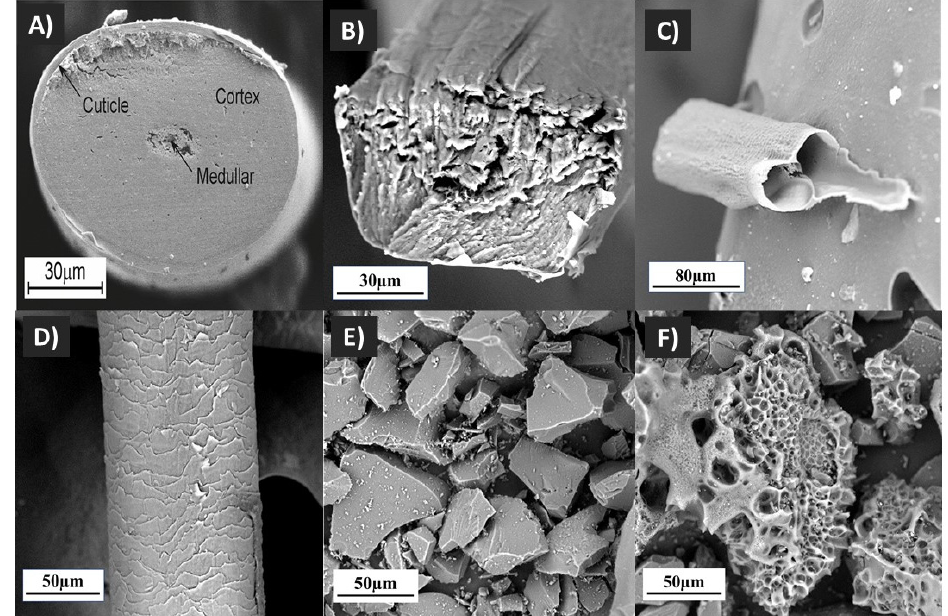
Figure 2. SEM micrographs of raw and carbonised human hair. ( A ) Cross section of human hair adapted from [44]. ( B ) Cross-section of human hair used in this study. ( C ) Carbonised human hair with a hollow microfibre pattern. ( D ) Human hair with cuticle layering around the fibre. ( E ) Non-activated carbon. ( F ) Activated carbon with porous structure.